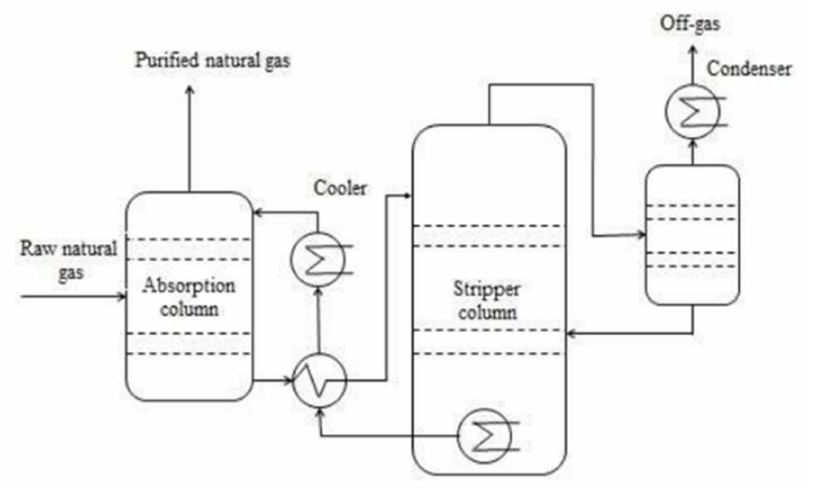
Figure 3. Process flow diagram of amine scrubber [31]. Reprinted/adapted with permission from Ref. [31]. Copyright 2022, John Wiley and sons.